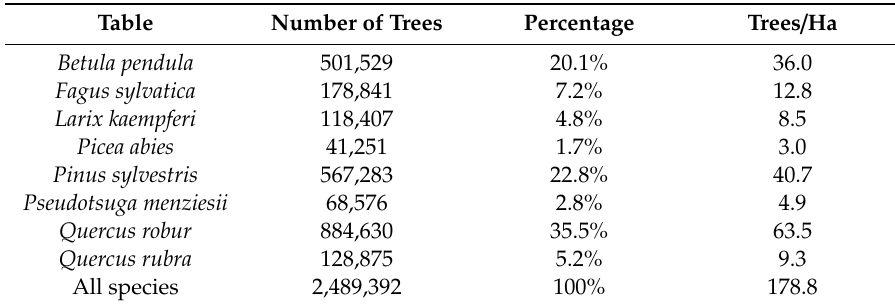
Table 5. The number of trees and density of the eight most common tree species on the Veluwe. The numbers are based on the prediction which combined the multitemporal Sentinel-2 spectral data with the ALS-derived crown structural